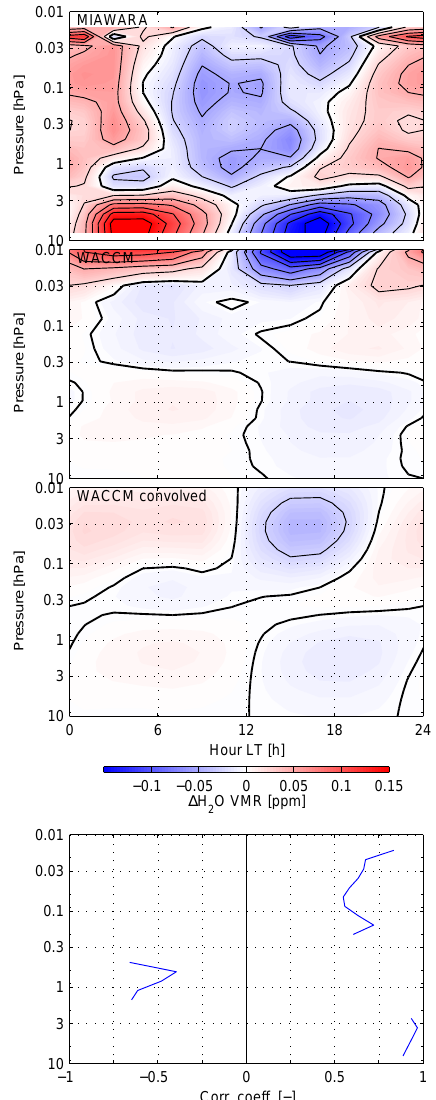
Fig. 3. Diurnal variations of water vapor [ppm] from observational (MIAWARA) and model (WACCM and WACCM convolved) data averaged over the months June to October. The contour line inter- val is 0.025ppm. The lowermost panel shows the linear correlation coefficients between MIAWARA and the convolved WACCM data. Correlations are only shown where they exceed 95% confidence ( p< 0 . 05). Times are given in local